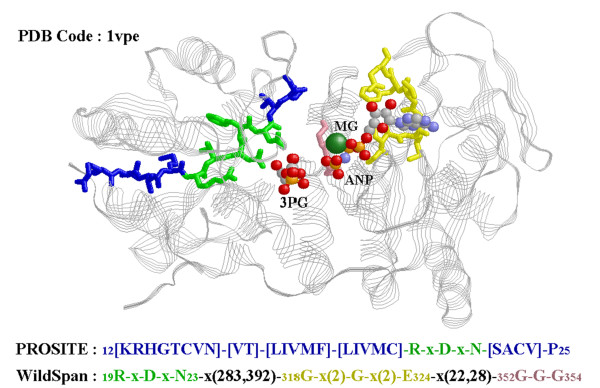
A W-pattern versus the PROSITE pattern for a family of interest. The W-pattern derived by WildSpan for Phosphoglycerate kinase (PS00111) versus the PROSITE pattern. The small numbers in patterns are the residues IDs in the PDB structure.